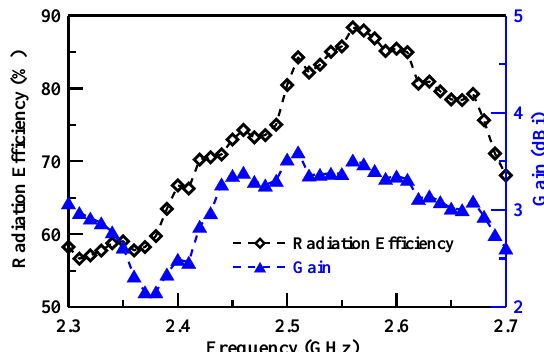
Figure 11. Lower band gain and radiation efficiency measurement results.